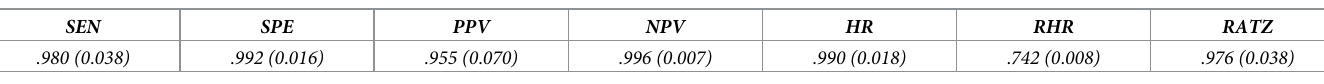
Table 2. Mean (SD) for overall test